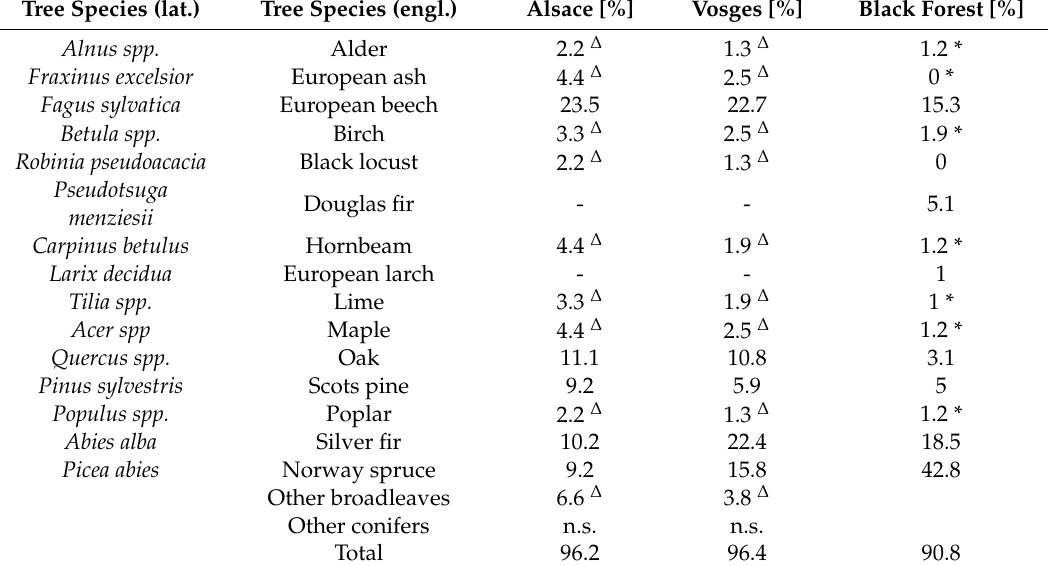
Table 2. Contribution of different tree species to regional forests in Alsace (F, larger area), Vosges (F, smaller area) and the Black Forest (D), related to forest area based on the latest inventories [37,38]. Tree Species